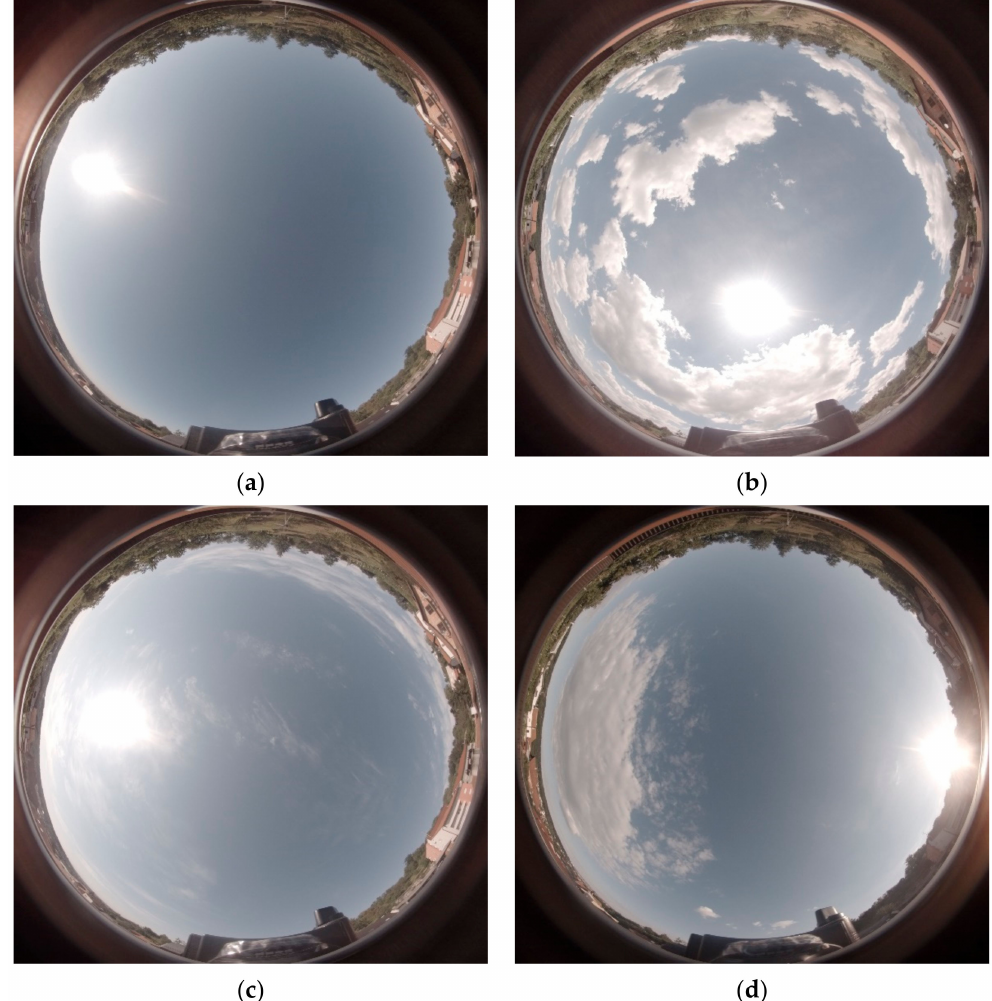
Figure 3. Ground-based sky